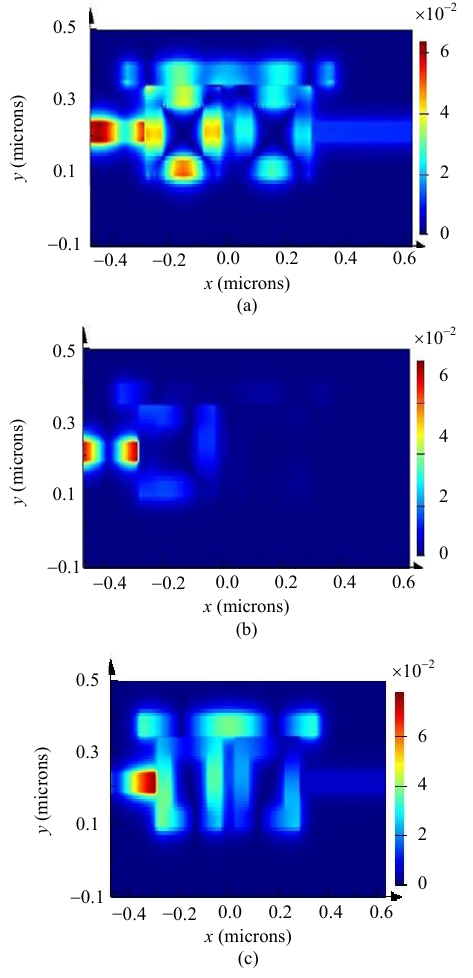
Fig. 3 Contour profiles of the H-fields for three wavelengths at (a) 520 nm, (b) 726 nm, and (c) 996 nm with no pressure.